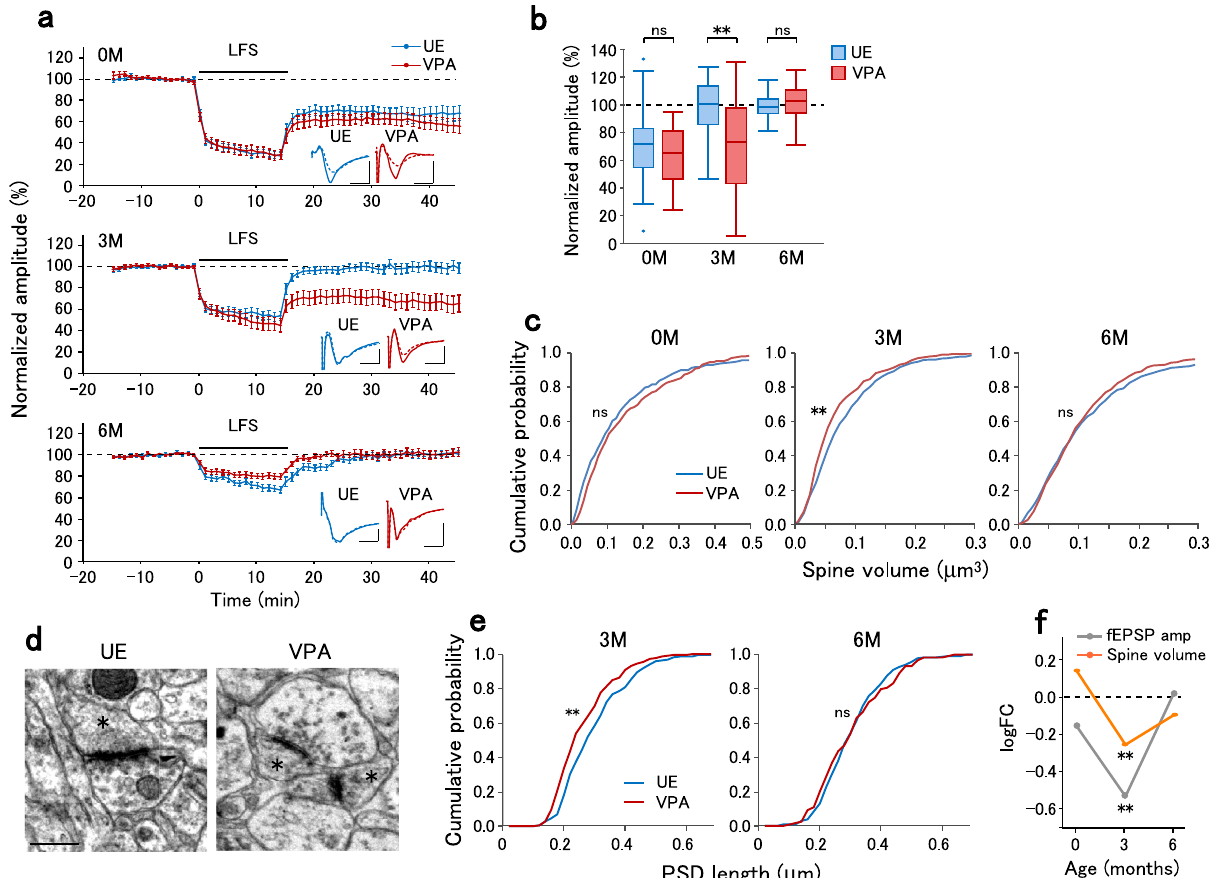
Fig. 2 Age-dependent modi fi cation of LTD and spine volume in VPA-exposed marmosets. a The time course of normalized fi eld EPSP amplitudes before and after LFS onset that were recorded from slices obtained at 0 M (top), 3 M (middle), and 6 M (bottom) in UE (blue) and VPA (red) animals. Error bars represent the SEM. Insets represent the average traces of fi eld EPSPs before ( − 10 to 0 min, solid lines) and after (30 to 40 min, dotted lines) LFS. n = 26 pathways in 12 animals (0 M UE), n = 15 pathways in 2 animals (0 M VPA), n = 20 pathways in 5 animals (3 M UE), n = 22 pathways in 5 animals (3 M VPA), n = 16 pathways in 2 animals (6 M UE), and n = 15 pathways in 1 animal (6 M VPA). b Normalized fi eld EPSP amplitudes in UE and VPA animals at post-LFS 30 – 40 min. The boxplots represent the median, quartiles, and data range. Two-sided t -test with Holm-Sidak correction between UE and VPA, p = 0.38 (0 M), p = 0.0020 (3 M), p = 0.76 (6 M). ** p < 0.01; ns, not signi fi cant. c Cumulative distribution of spine volume in UE and VPA animals at 0, 3, and 6 M. n = 227 spines in 3 animals (0 M UE), n = 291 spines in 2 animals (0 M VPA), n = 467 spines in 5 animals (3 M UE), n = 399 spines in 2 animals (3 M VPA), n = 472 spines in 6 animals (6 M UE), and n = 406 spines in 3 animals (6 M VPA). Two-sided Kolmogorov – Smirnov test between UE and VPA animals, p = 0.089 (0 M), p = 0.0025 (3 M), p = 0.64 (6 M). ** p < 0.01; ns not signi fi cant. d Representative electron micrograph of synapses in UE and VPA animals at 3 M. These images are representative of 234 PSDs (UE) and 230 PSDs (VPA). Asterisks indicate dendritic spines. Scale bar, 0.5 µ m. e Cumulative distribution of the PSD length in UE and VPA animals at 3 M and 6 M. n = 234 PSDs in 2 animals (3 M UE), n = 230 PSDs in 2 animals (3 M VPA), n = 236 PSDs in 2 animals (6 M UE), and n = 119 PSDs in 1 animal (6 M VPA). Two-sided Kolmogorov – Smirnov test between UE and VPA animals at 3 M, p = 0.0026; 6 M, p = 0.69. ** p < 0.01; ns not signi fi cant. f logFC values for the normalized post-LFS fi eld EPSP amplitudes and the spine volume plotted as a function of age. ** p < 0.01 (statistical tests and p values are as in the legends of b and c